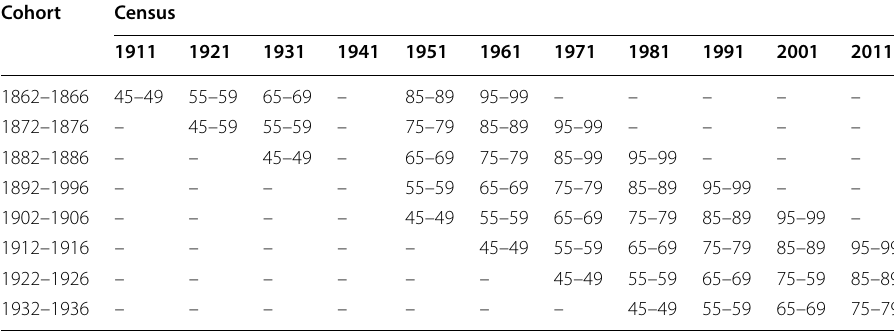
Source: Italian censuses